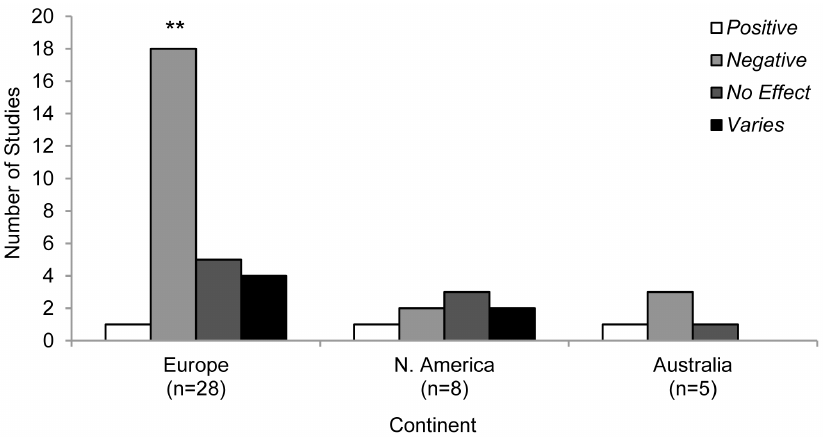
Figure 7. Number of studies (n=41) investigating the effects of winter recreation on fauna across three continents. **P , 0.01 indicates a significant difference between the number of positive and negative effects